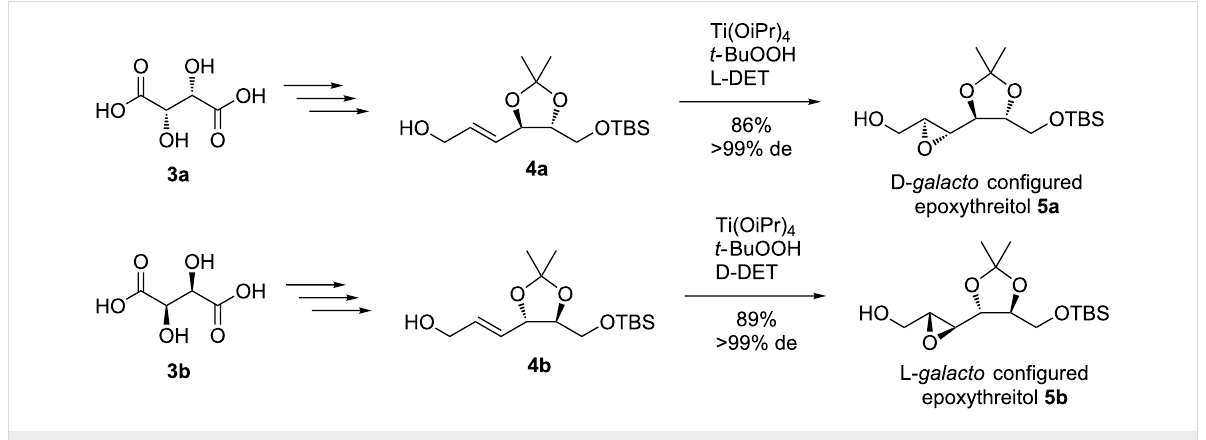
Scheme 1: Sharpless epoxidation to gain D- galacto- 5a and L- galacto -configured epoxythreitol 5b .